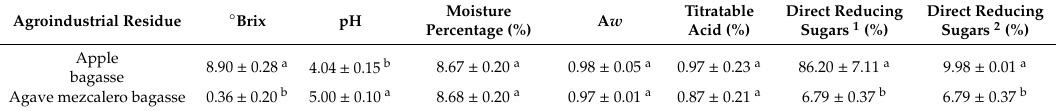
Values are the mean ± standard deviation. Means with the same letters within each column do not differ statistically by Tukey ’ s test ( p ≤ 0.05). 1 Direct reducing sugars before washing apple bagasse; Table 1. Physicochemical characteristics of apple bagasse and agave mezcalero bagasse.